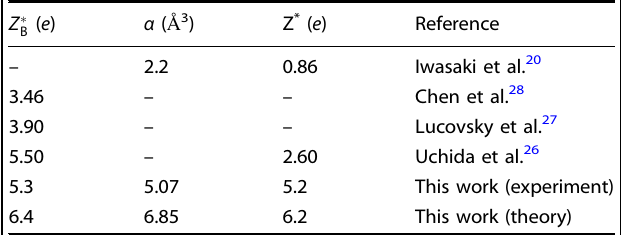
Table 3. Comparison of Born charge, polarizability, and local (ionic) charge from the E u mode of 1T-HfS 2